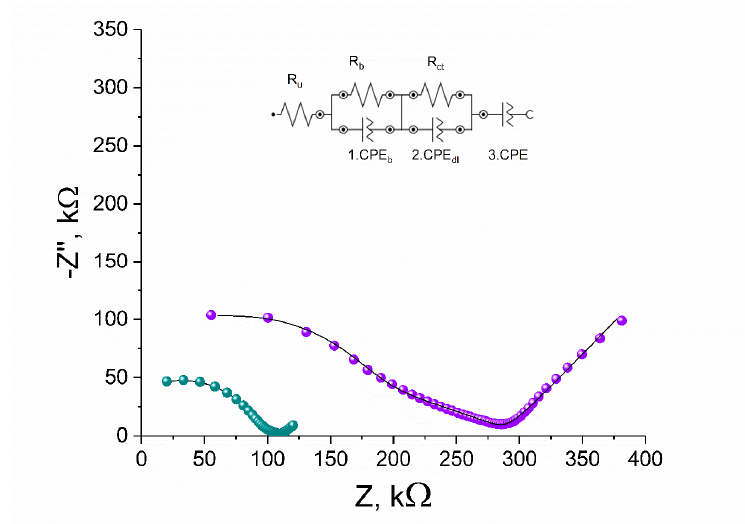
Figure 10. Impedance spectrum of GCD/RuO 2 •xH 2 O/K + -ISM (blue) and GCD/RuO 2 /K + -ISM (violet) electrode in 0.01 M KCl solution and equivalent electrical circuits. Frequency range: 100 kHz–0.01 Hz. Equivalent circuits are shown as insets (solid lines represent data fits). Table 3. Electrical parameters of studied electrodes.